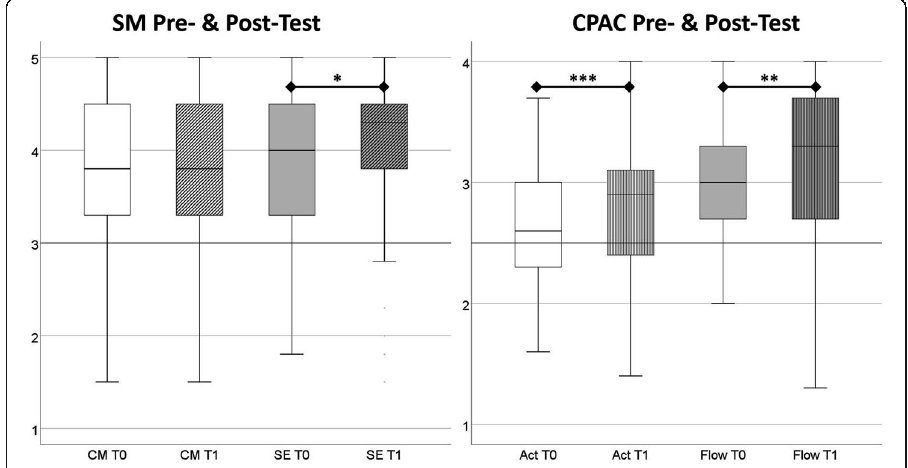
Fig. 2 Boxplots of Science Motivation Subscales CM “ Career Motivation ” and SE “ Self-Efficacy ” and Creativity Subscales “ ACT ” and “ FLOW ” at T0 = pre-test and T1 = post-test; * = p = .019; *** = p ≤